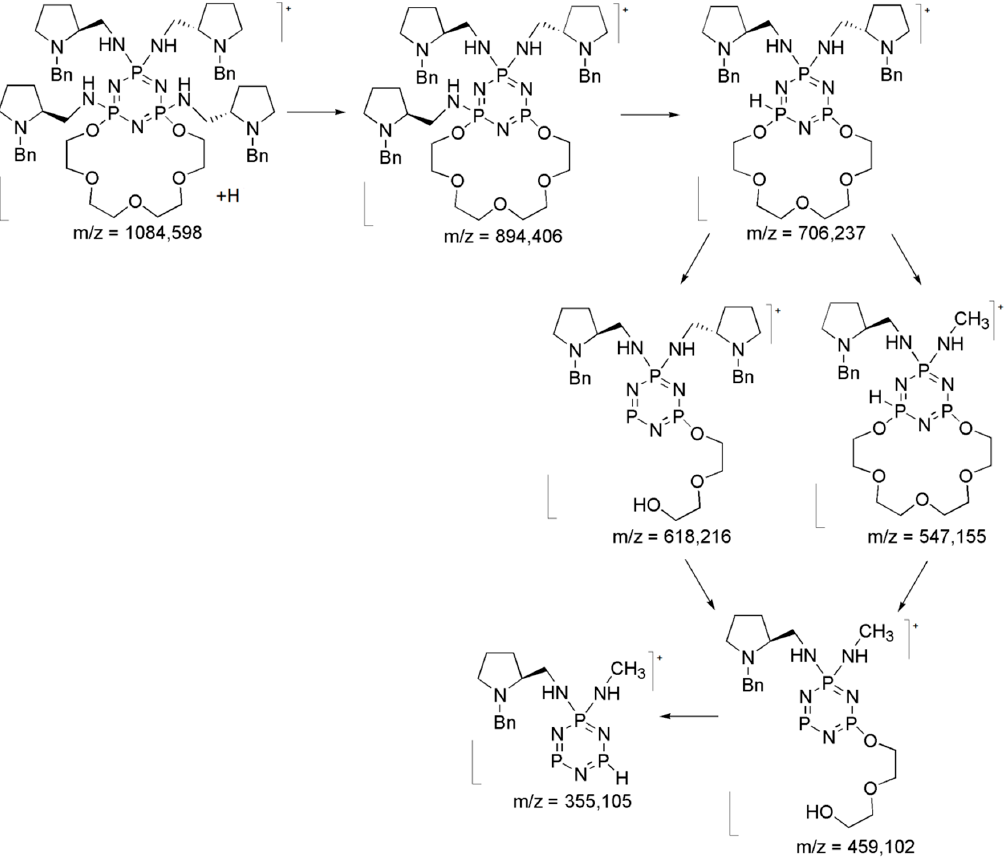
Scheme 6. The first fragmentation pathway of the free ligand.